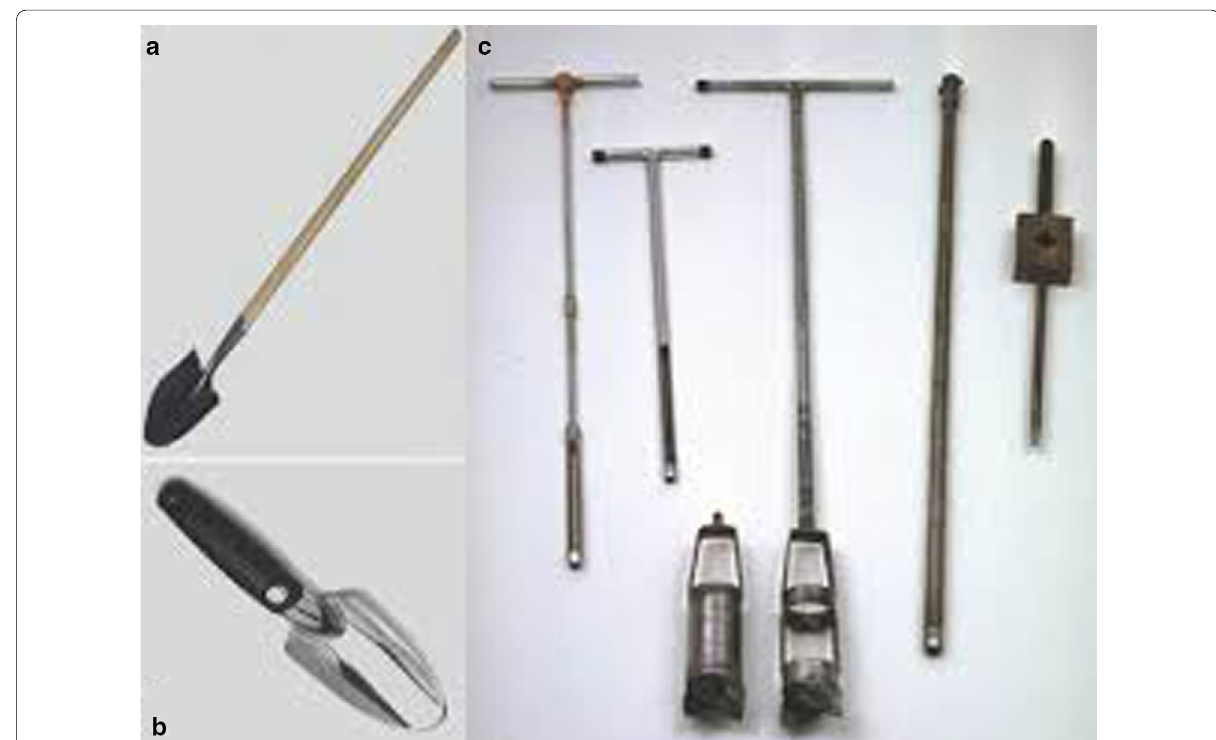
Fig. 2 Various samplers with different sizes used as tools to take nematode samples. a A spade to collect large samples of fairly undisturbed soils and roots, b A trowel to obtain samples of medium volumes, and c Soil tubes (augers) to get many sub‑samples